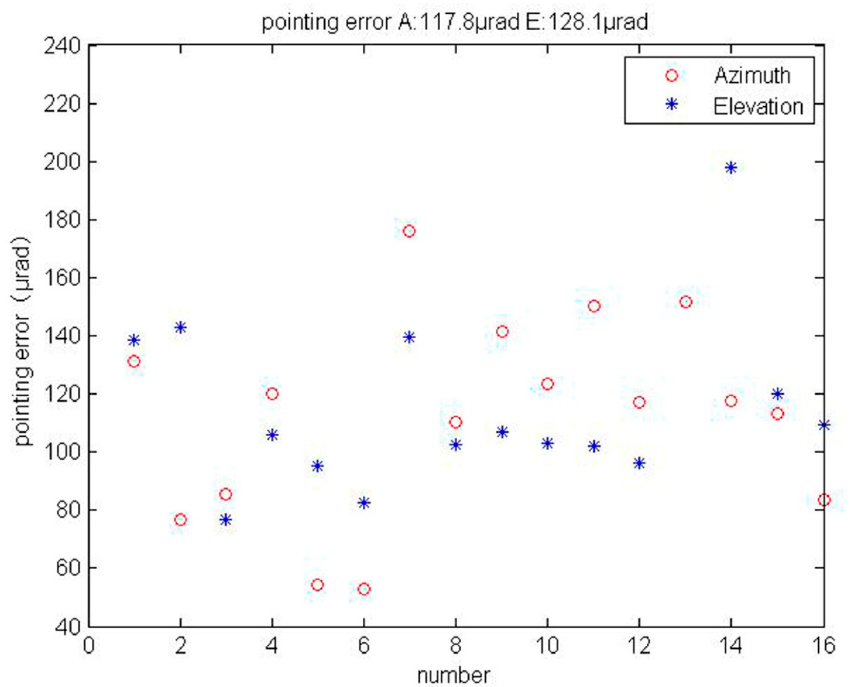
Figure 9. Pointing error of azimuth and elevation. Azimuth pointing error is 117.8 μ rad and elevation pointing error is 128.1 μ rad.